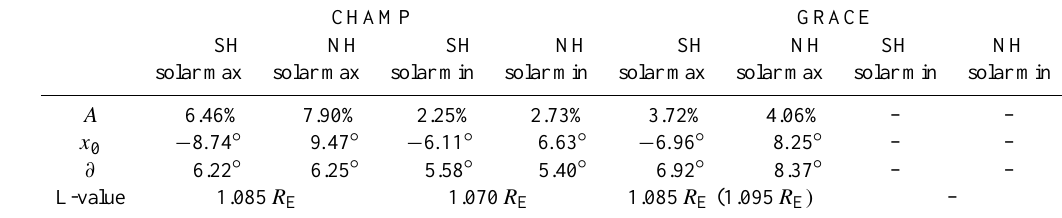
Table 1. The value of Gaussian fit and the peak L-value corresponding to Fig. 9. CHAMP GRACE